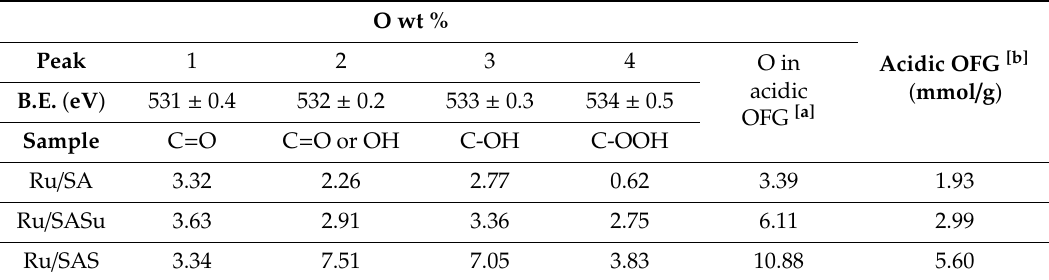
Table 3. Distribution of OFG as O wt% determined from the deconvolution of the O 1s XPS